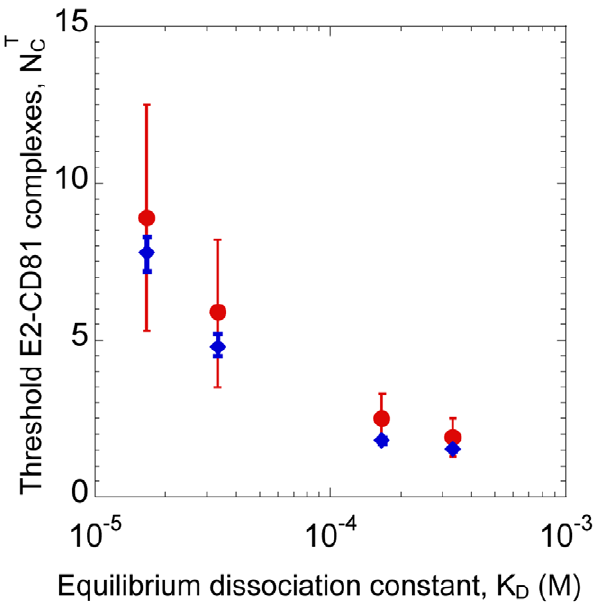
Figure 4. Threshold number of E2-CD81 complexes. Estimates of N T for different values of K D obtained from fits of model predictions to C the data of Zhong et al. [15] (circles) and Koutsoudakis et al. [13] (diamonds) (Fig. S4). Error bars are 95% confidence intervals.